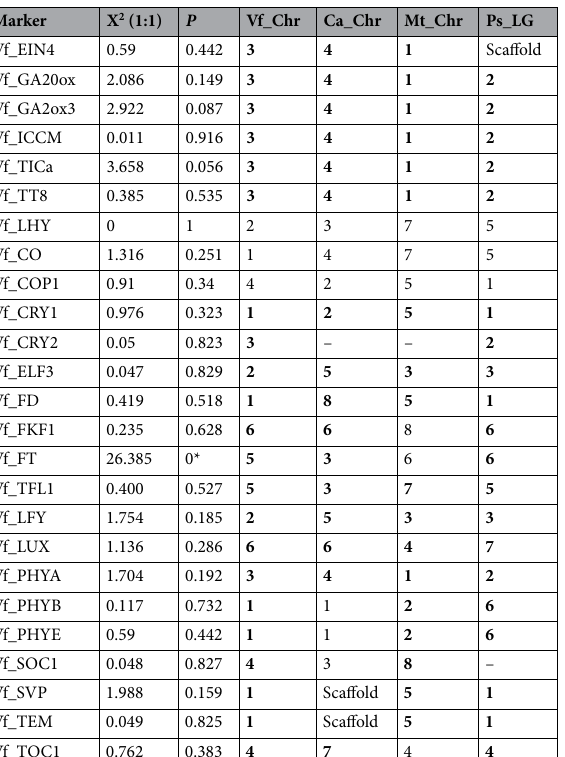
Table 3. Genetic segregation, chi-square test and location of the flowering time gene markers in faba bean (Vf) and related legume species: Ca, Cicer arietinum ; Mt, Medicago truncatula and Ps, Pisum sativum ). Bold values highlight syntenic chromosomes (Chr)/and linkage groups (LGs). Lack of fit to the expected 1:1 segregation is indicated by an